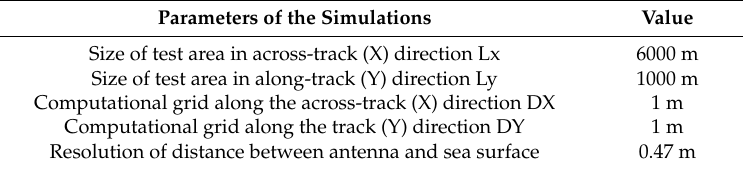
Table 2. Main parameters of the single measurement numerical